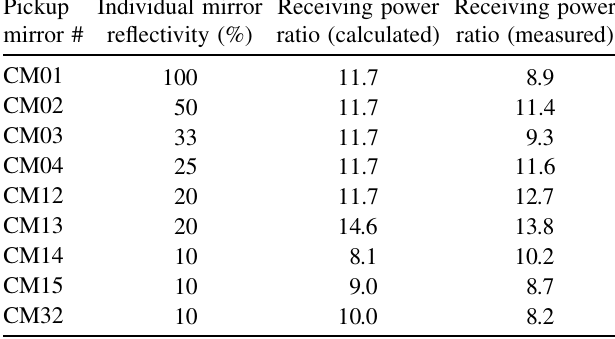
TABLE I. Laser power received at each measurement station in the simultaneous profile scan system. The second column shows the reflection ratio of individual pickup optics used in each measurement station. The third and fourth columns show the light power received at each measurement station when all pickup optics are in place. The difference between calculated and measured numbers is due to the insertion of beam samplers in the LTL and the discrepancy between the actual mirror reflectivity and its nominal value.